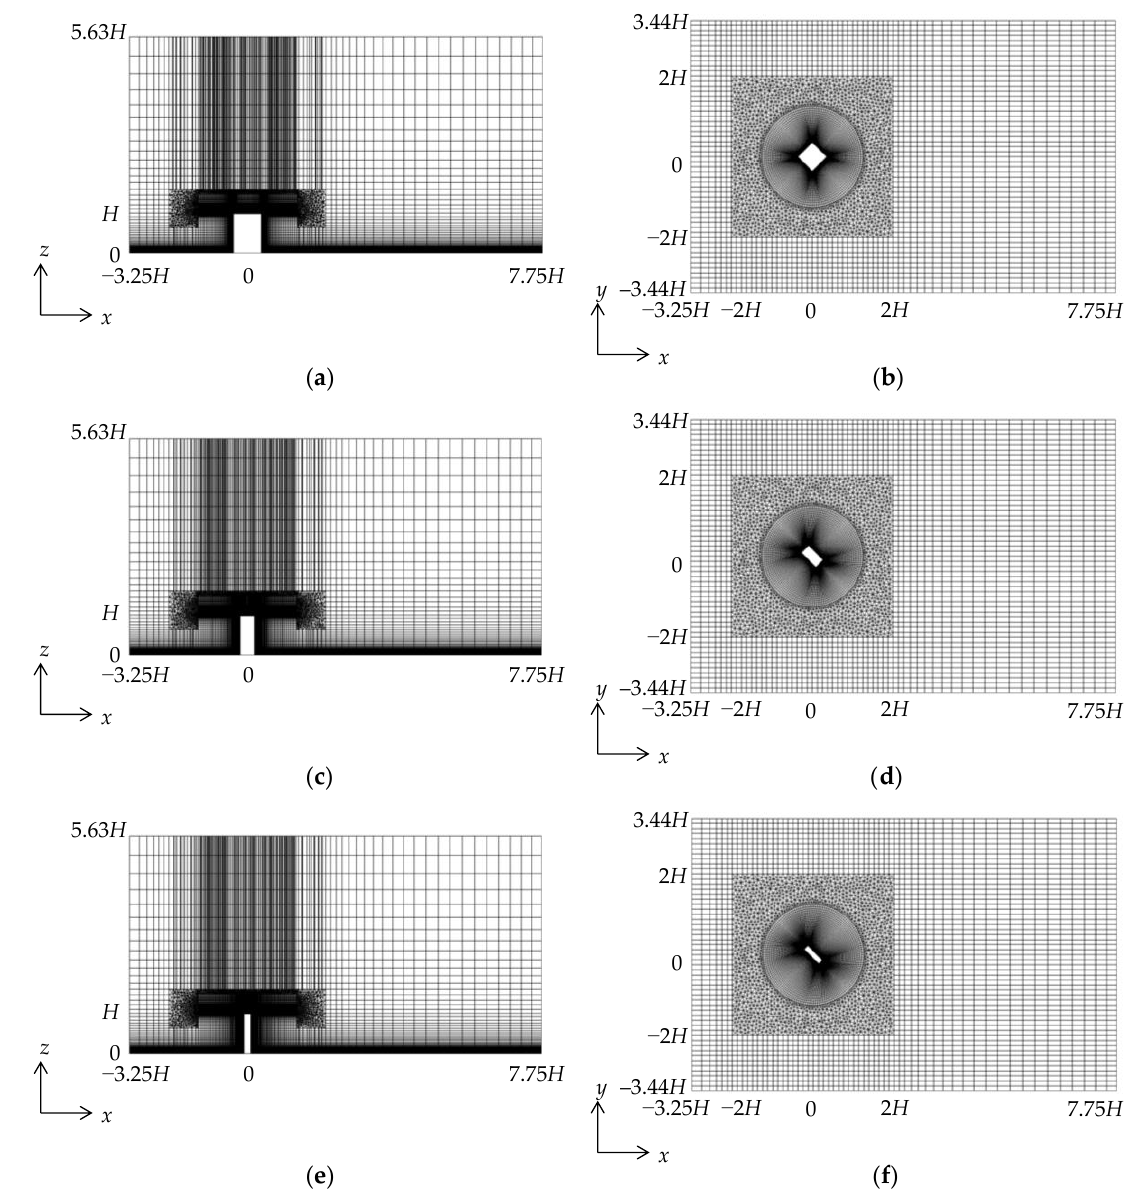
Figure 2. Computational domains and grids. ( a ) Vertical cross section for run case 100_450 at y = 0; ( b ) Horizontal cross section for run case 100_450 at z = 0; ( c ) Vertical cross section for run case 050_450 at y = 0; ( d ) Horizontal cross section for run case 050_450 at z = 0; ( e ) Vertical cross section for run case 025_450 at y = 0; ( f ) Horizontal cross section for run case 025_450 at z = 0. Here, H (=0.16 m) is the height of the building.